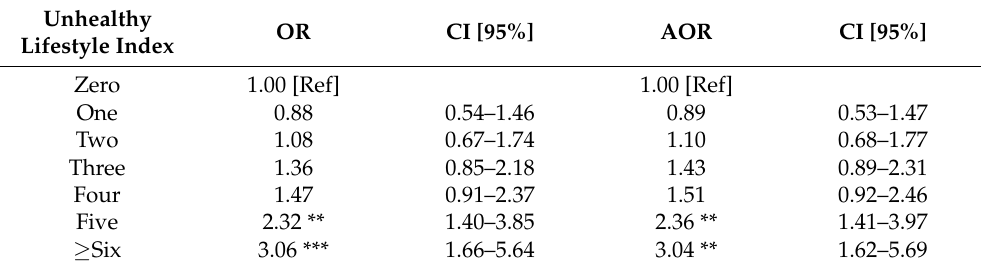
Table 4. Odds of developing psychological distress at follow-up with increases in the baseline unhealthy lifestyle index using unadjusted odds ratios (OR) and adjusted odds ratios (AOR). Unhealthy OR CI [95%] Lifestyle Index